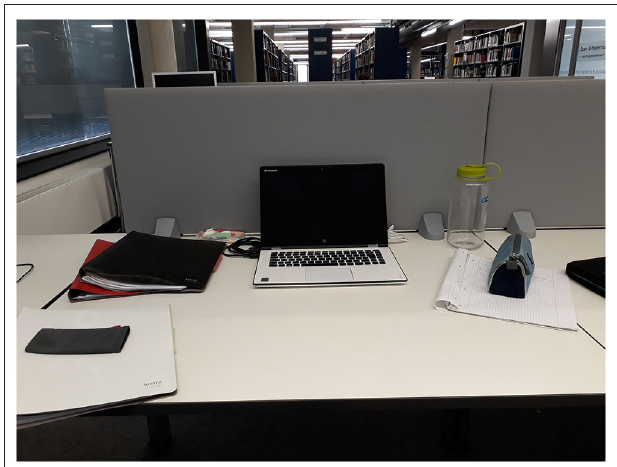
FIGURE 8 | Students use a lot of equipment in library, e.g., laptops and books. There are no or very limited storage possibilities, which prevents them from getting up and moving during breaks (Photo: U2